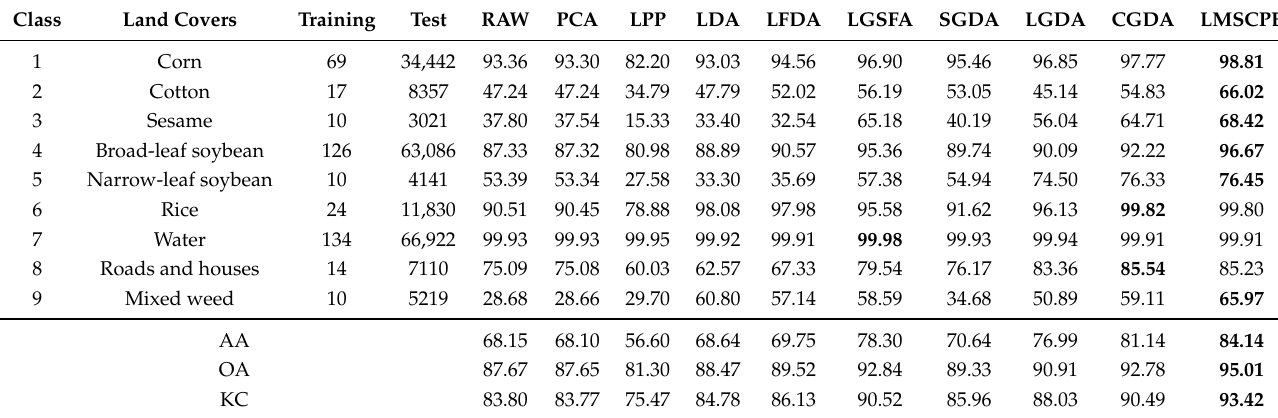
Table 5. Classification results (%) of each type of land covers (t = 0.2%) with the NN classifier on the LongKou data set. (AA—average classification accuracy, OA—overall classification accuracy, KC—kappa coefficient, and the best results of a row are marked in